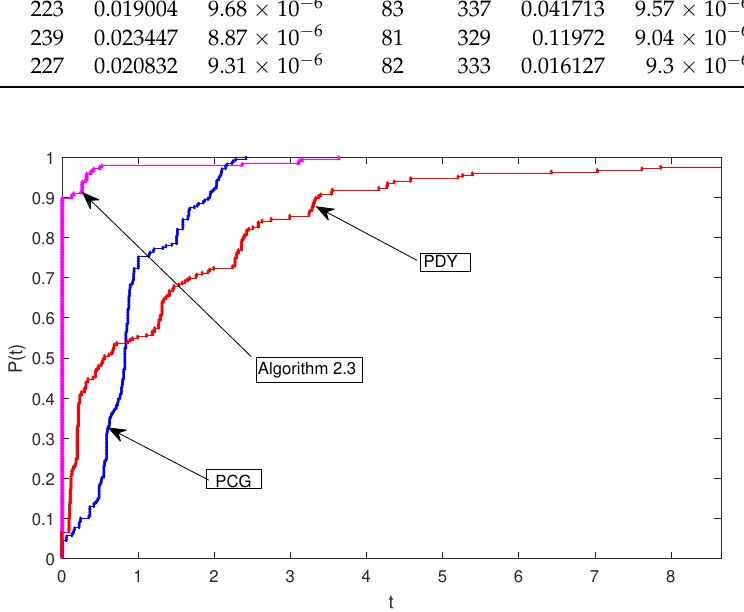
Figure 1. Performance profiles for the number of